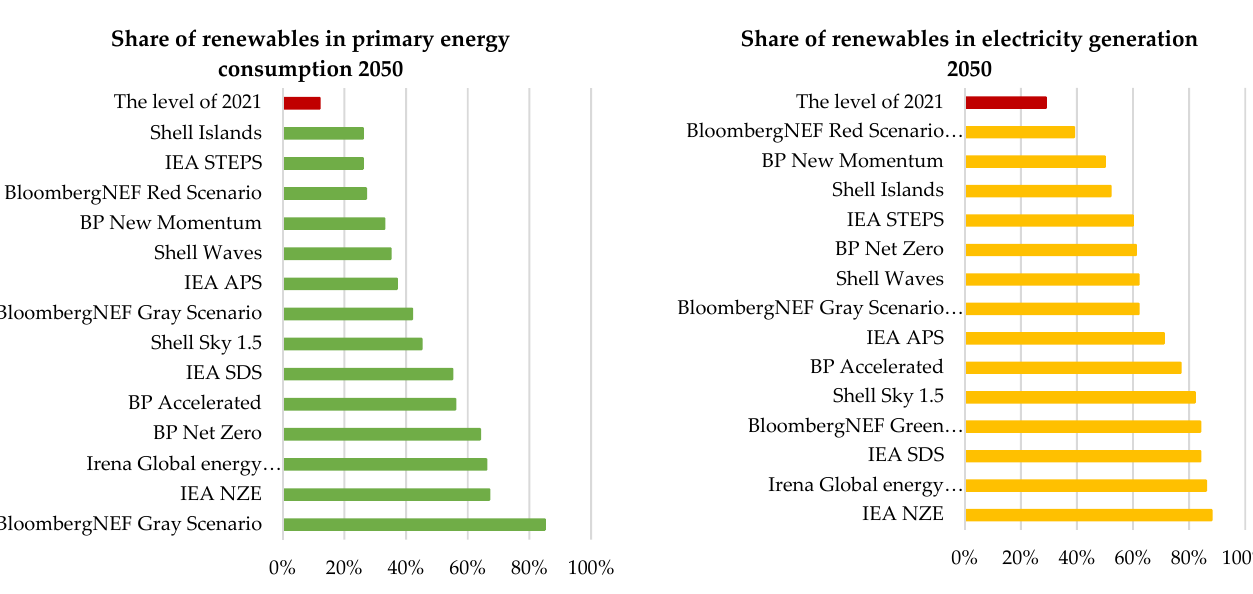
Figure 2. Forecast for the share of renewables in the global energy mix and electricity production by 2050. Source: Created by the authors using data from [1,2,7,27,29].